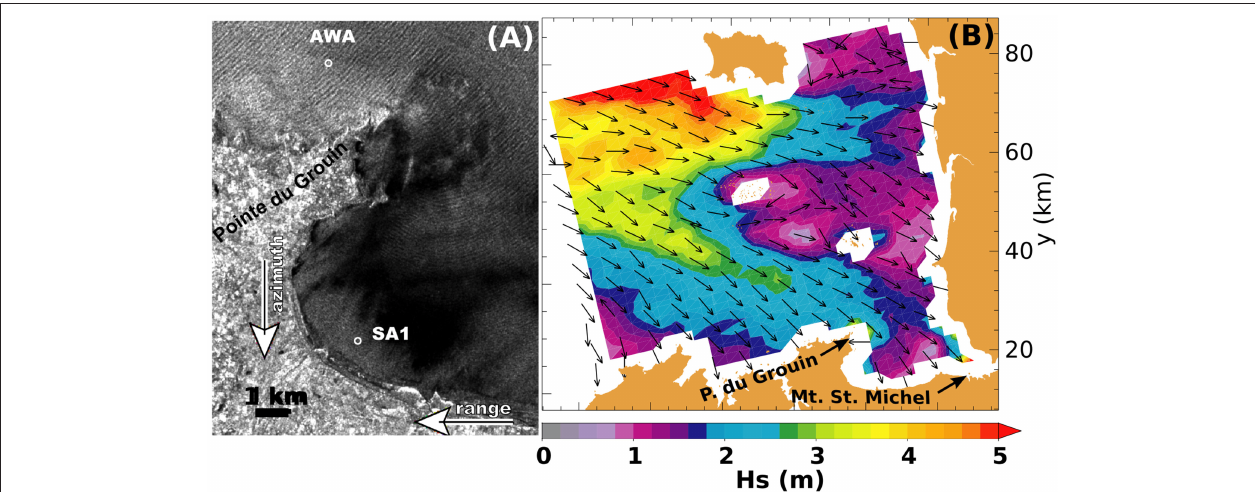
FIGURE 10 | (A) extract from an Envisat IW mode image, March 2003 (see Collard et al., 2005) and (B) map of wave heights and mean direction estimated from the Single Look Complex